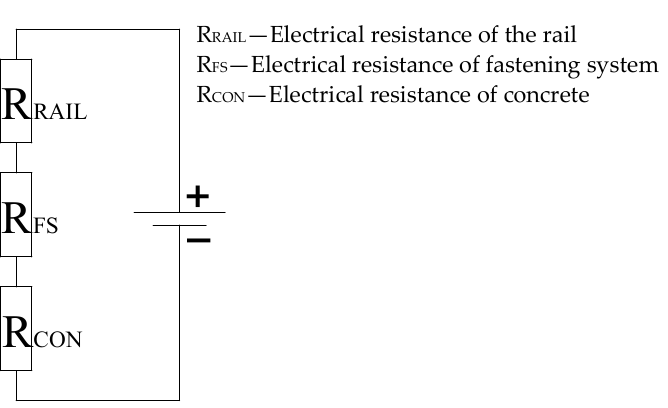
Figure 11. Current circuit during the laboratory test as resistors connected in series.